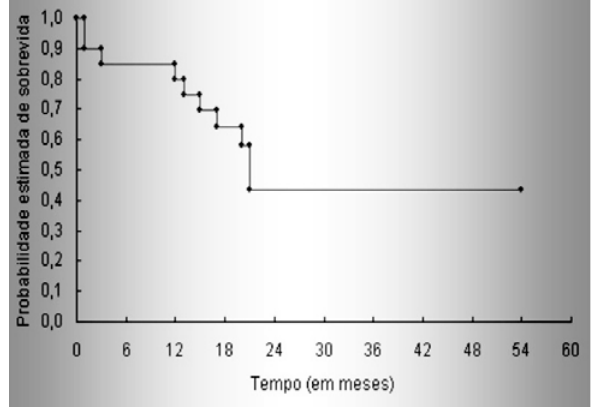
Fig. 4 - Curva atuarial - método de